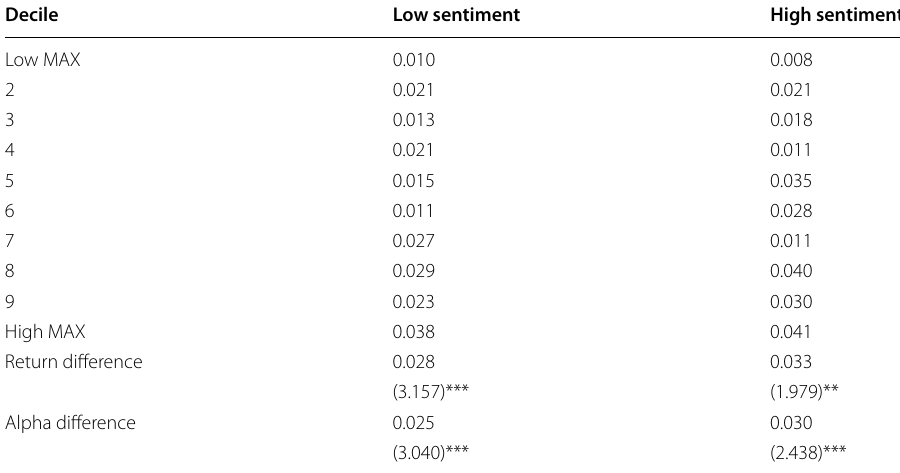
Table 15 Returns on portfolios of cryptocurrencies sorted by MAX after controlling for investor sentiment